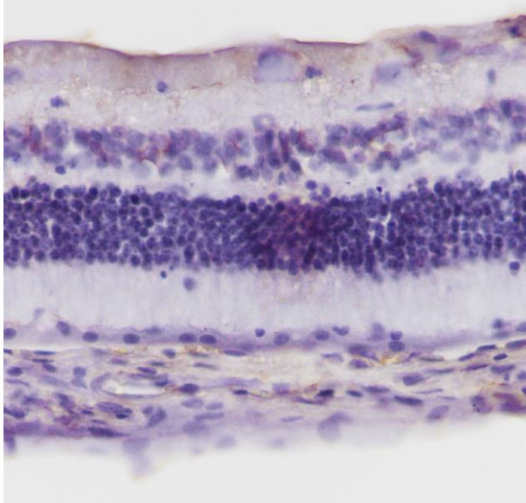
Figure 2. Group C. Negative ( − ) immunohistochemical staining.IL-6 ×